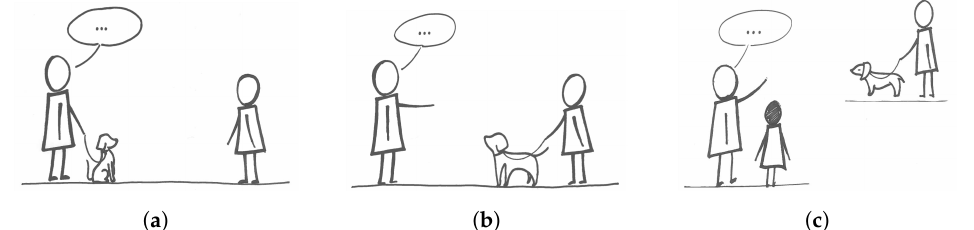
Figure 1. Picture-sentence matching task: ( a ) Speaker-related domain; ( b ) Hearer-related domain; ( c ) Non-participant-related